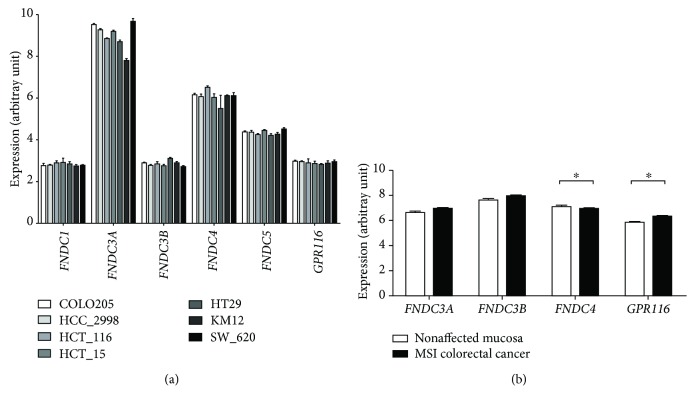
Microarray expression values retrieved from the GEO database (data sets GDS4296 and GDS4515). FNDCs and GPR116 are expressed in several colorectal cancer cell lines from the NCI-60 panel (24) (a). In human MSI colorectal cancer, FNDC4 is significantly downregulated (p = 0.047), whereas GPR116 is upregulated (p = 0.014) (25) (b). ∗
p < 0.05.